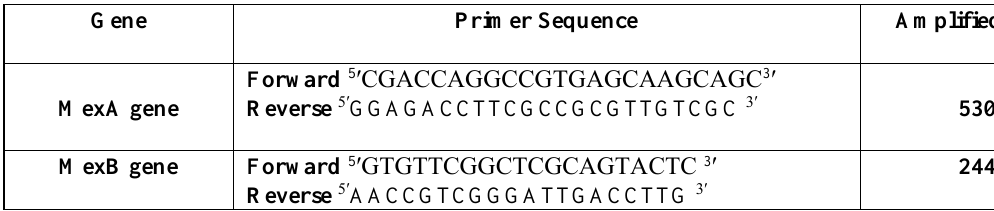
Table 1. MexA/MexB genes primers.